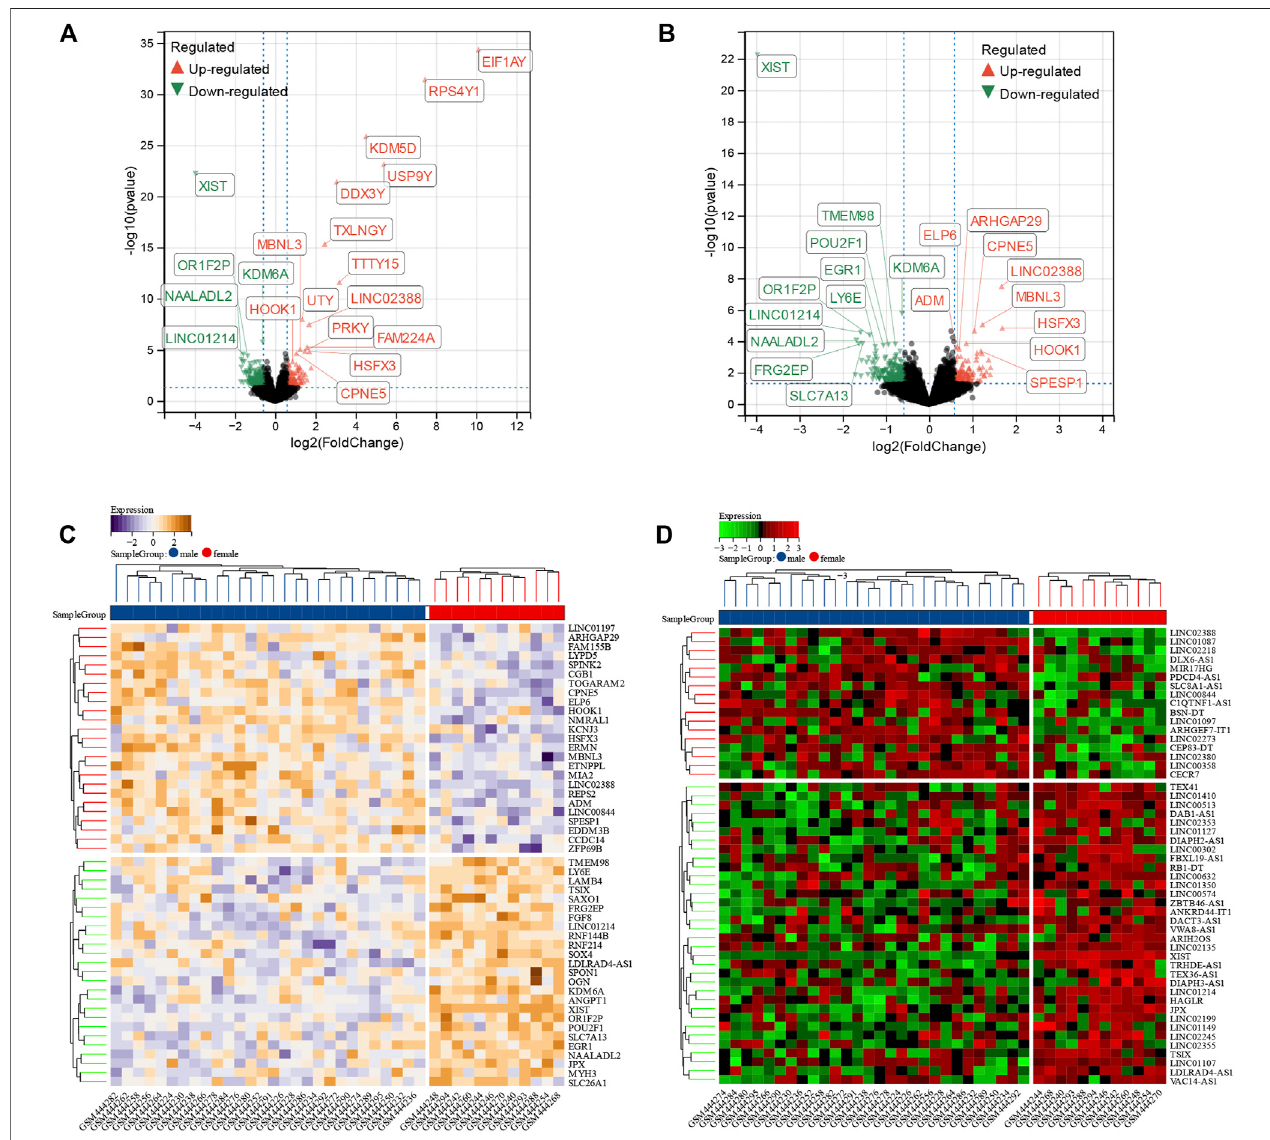
FIGURE 3 | Identi fi cation of sex difference DEGs in DCM. (A) The volcano plot of all DEGs of male and female DCM patient myocardial tissues. The differences are set as p value < 0.05 and |log FC| > 1.5. (B) The volcano plot of all DEGs of male and female DCM patients after excluding the genes on Y chromosomes. The differences are set as p value < 0.05 and |log FC| > 1.5. (C) Heatmap showing 50 signi fi cantly DEGs of male and female DCM patients after excluding the genes on Y chromosomes. (D) Heatmap showing 50 signi fi cant DE-lncRNAs of male and female DCM patients after excluding the genes on Y chromosomes.